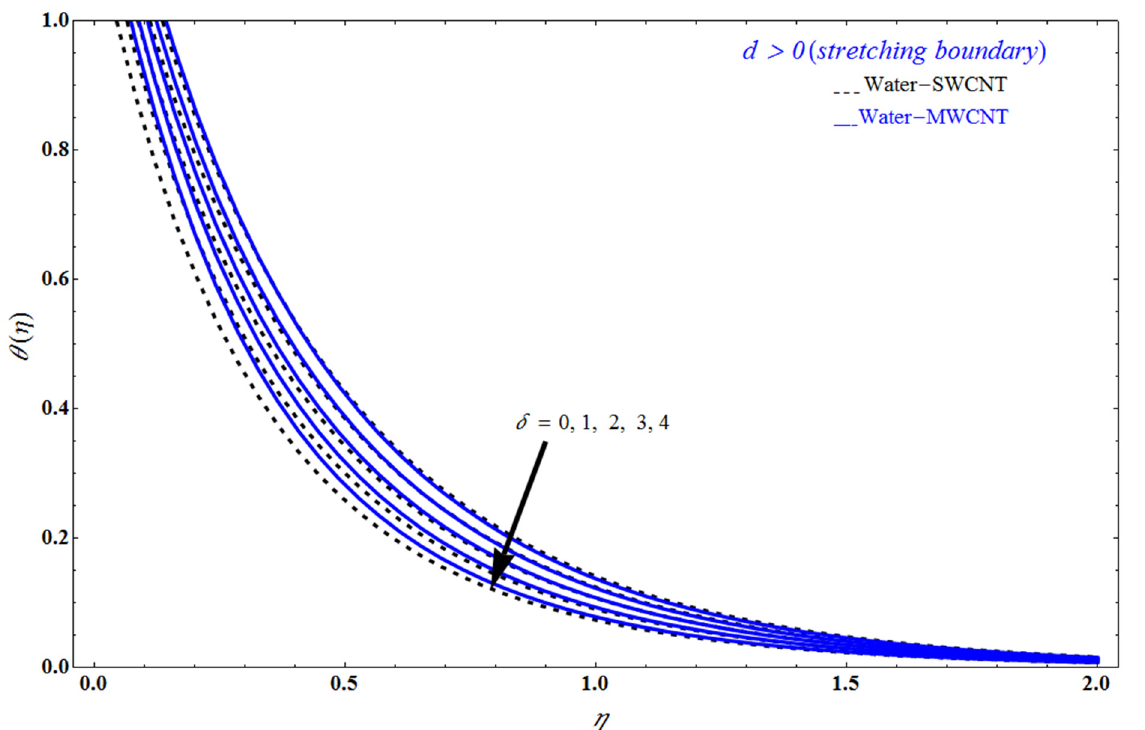
Figure 10. Impact of temperature profile θ ( η ) versus similarity variable η for numerous values of B ∗ , respectively.